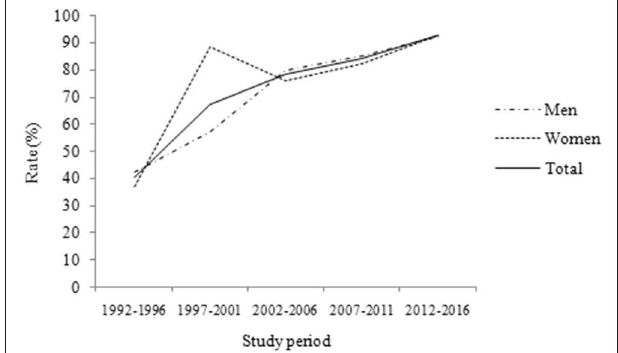
FIGURE 1 | The proportion of diagnosis using neuroimaging over time during the 25-year study period. It shows that the rate of diagnosis using neuroimaging increased both in men and in women during the 25-year study period ( P < 0.001).